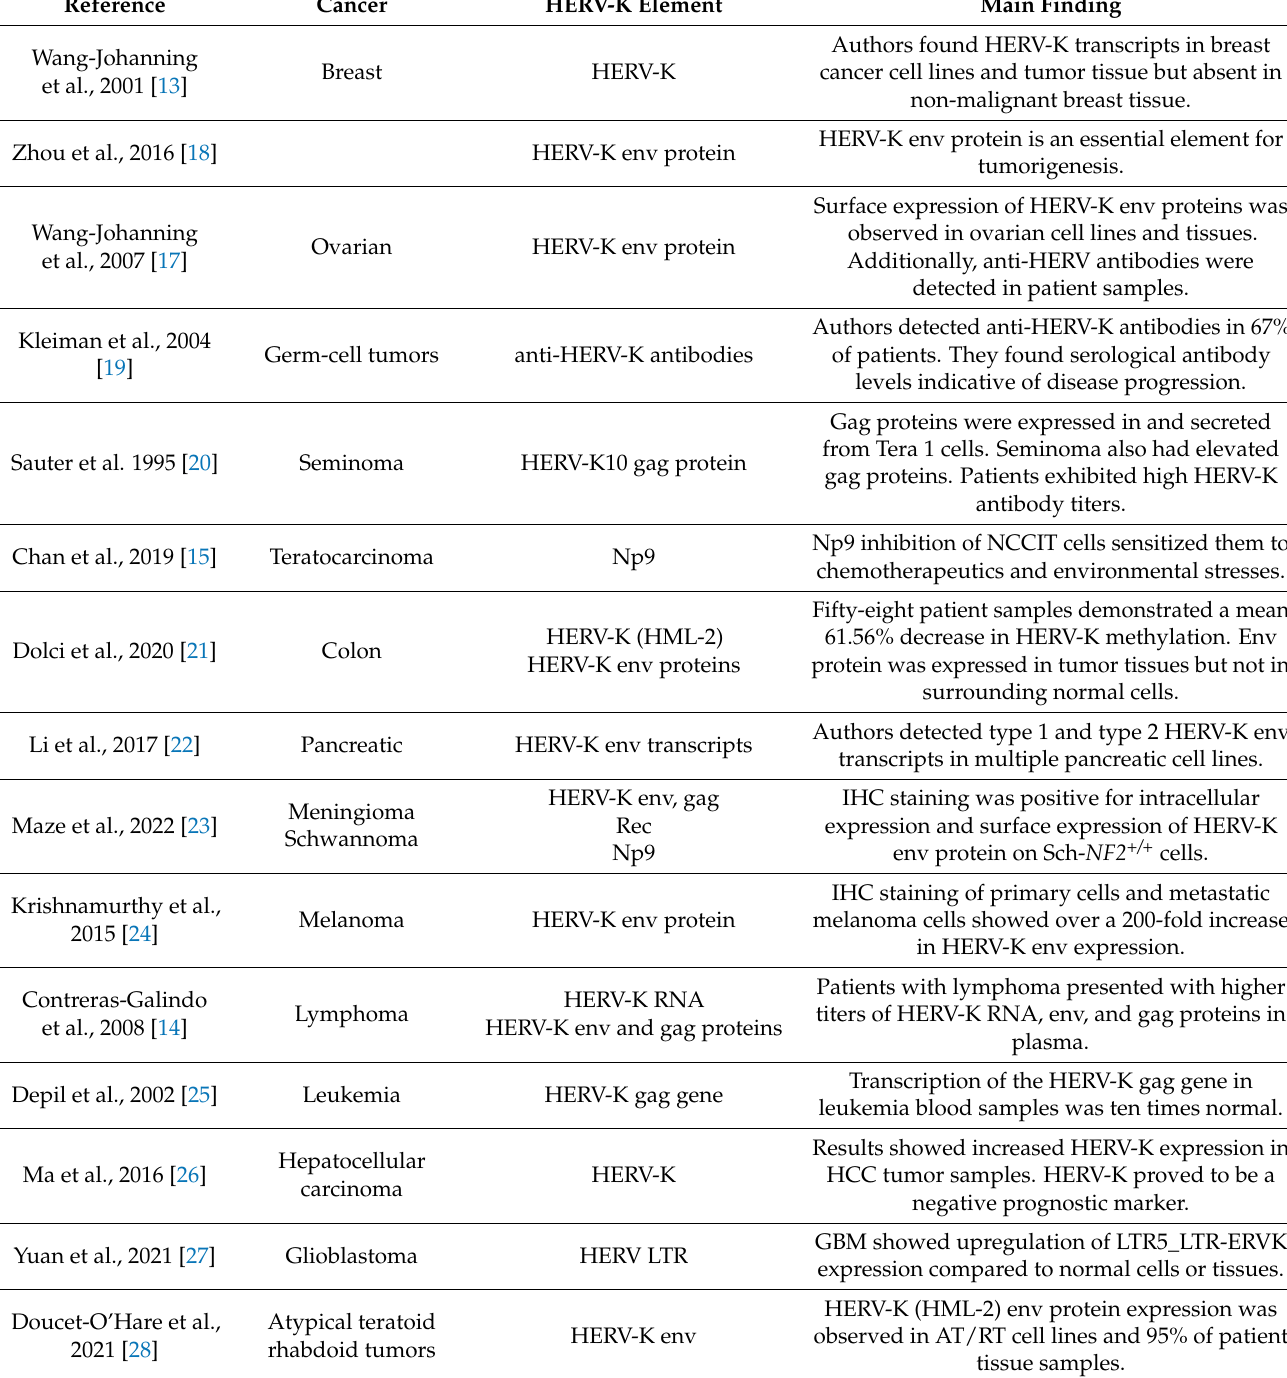
Table 1. Expression of HERV-K elements in